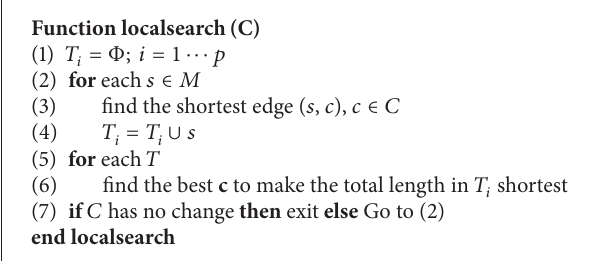
Algorithm 4: The modified VNS algorithm for the 𝑝 -median problem.